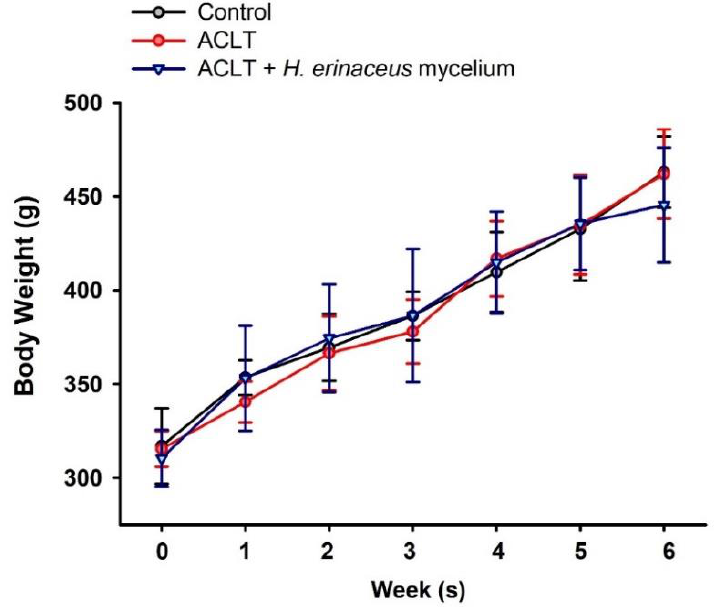
Figure 1. Body weight gain during the experimental period. Body weight was measured during the experimental period. ( n = 6 for each group).